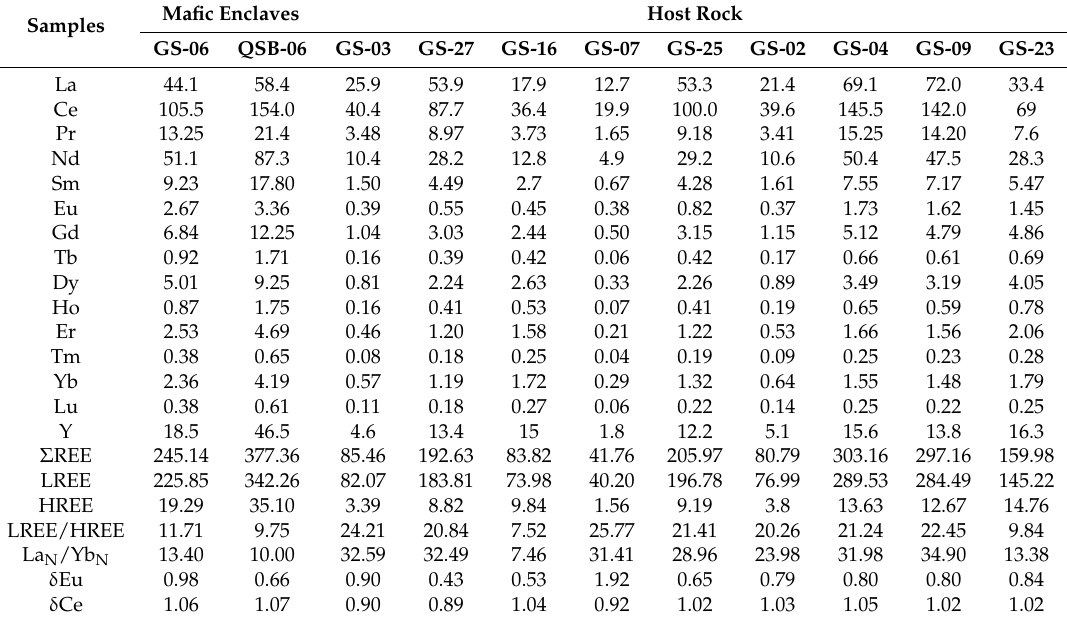
Table 5. REE content of the Qingshanbao complex and their mafic enclaves (wt/10 − 6 ). Mafic Samples